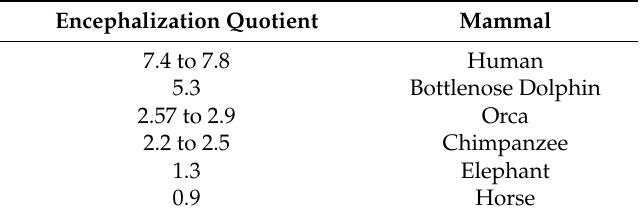
Table A1. Encephalization quotient. Data are from Roth and Dicke [47] except for orcas. The lower orca EQ is from Marino [48], and the higher orca EQ is from Woods and Evans